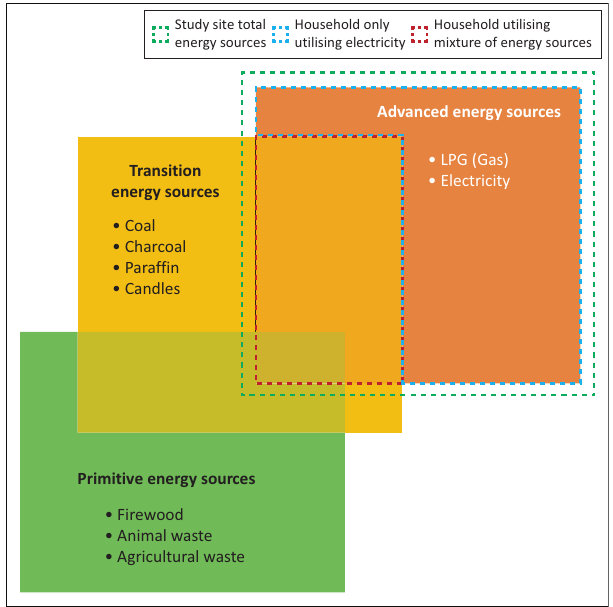
FIGURE 5: Location of study site households within the energy stacking